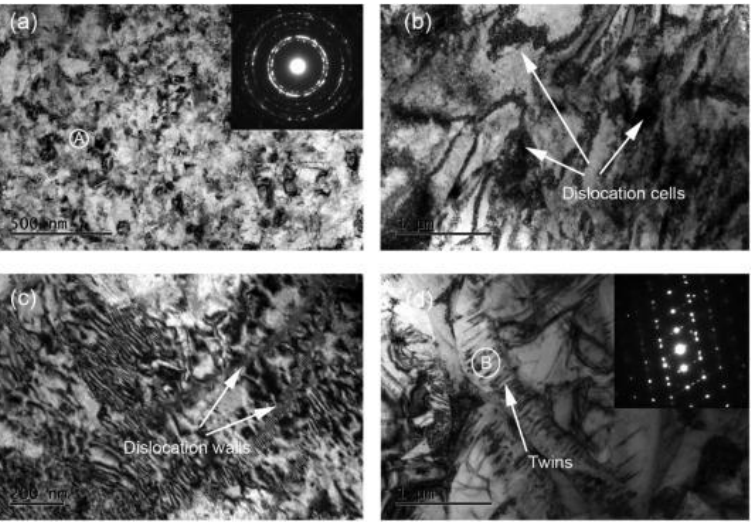
Figure 7. TEM images of USRP’ed Ti6Al4V at a depth of ( a ) 5 μm , ( b ) 20 μm , ( c ) 100 μm , and ( d ) 200 μm. Reprinted with permission from ref. [58]. Copyright 2021 Elsevier. ( d ) 200 µ m. Reprinted with permission from ref. [58]. Copyright 2021